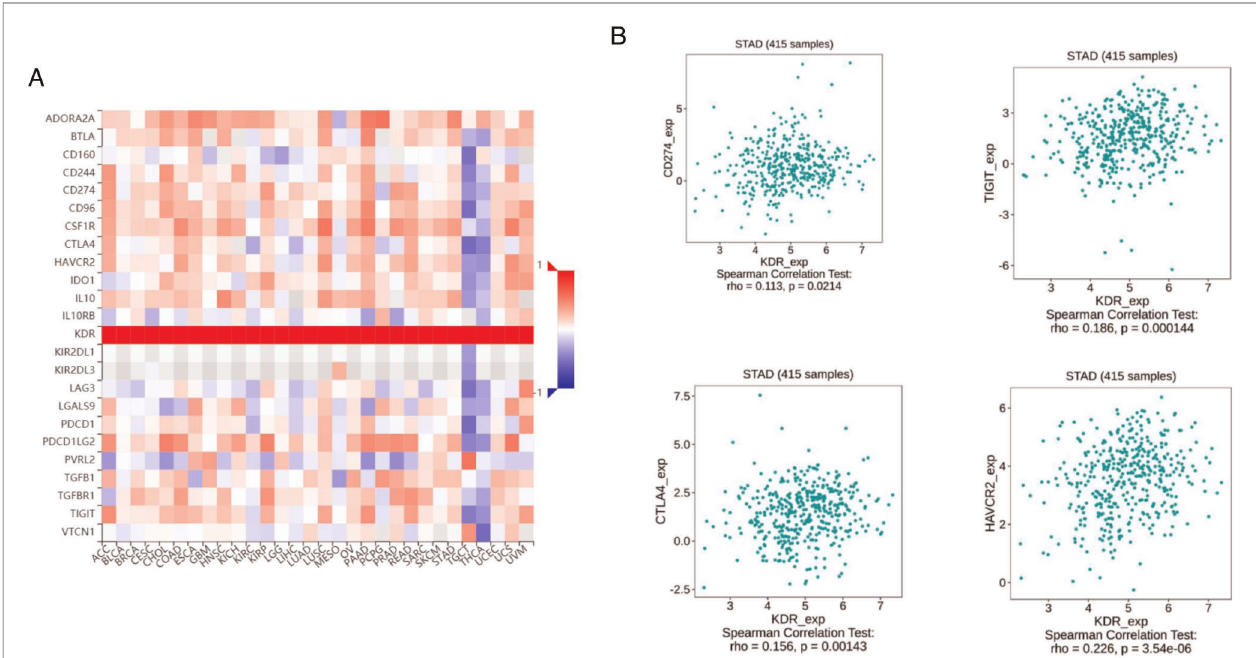
FIGURE 7 | Correlation between VEGFR expression and immunoinhibitors in GC. ( A ) The heat map shows the correlation between VEGFR and immunosuppressive factors in different cancers. ( B ) Line graph shows the correlation of VEGFR with speci fi c immune indicators in GC.